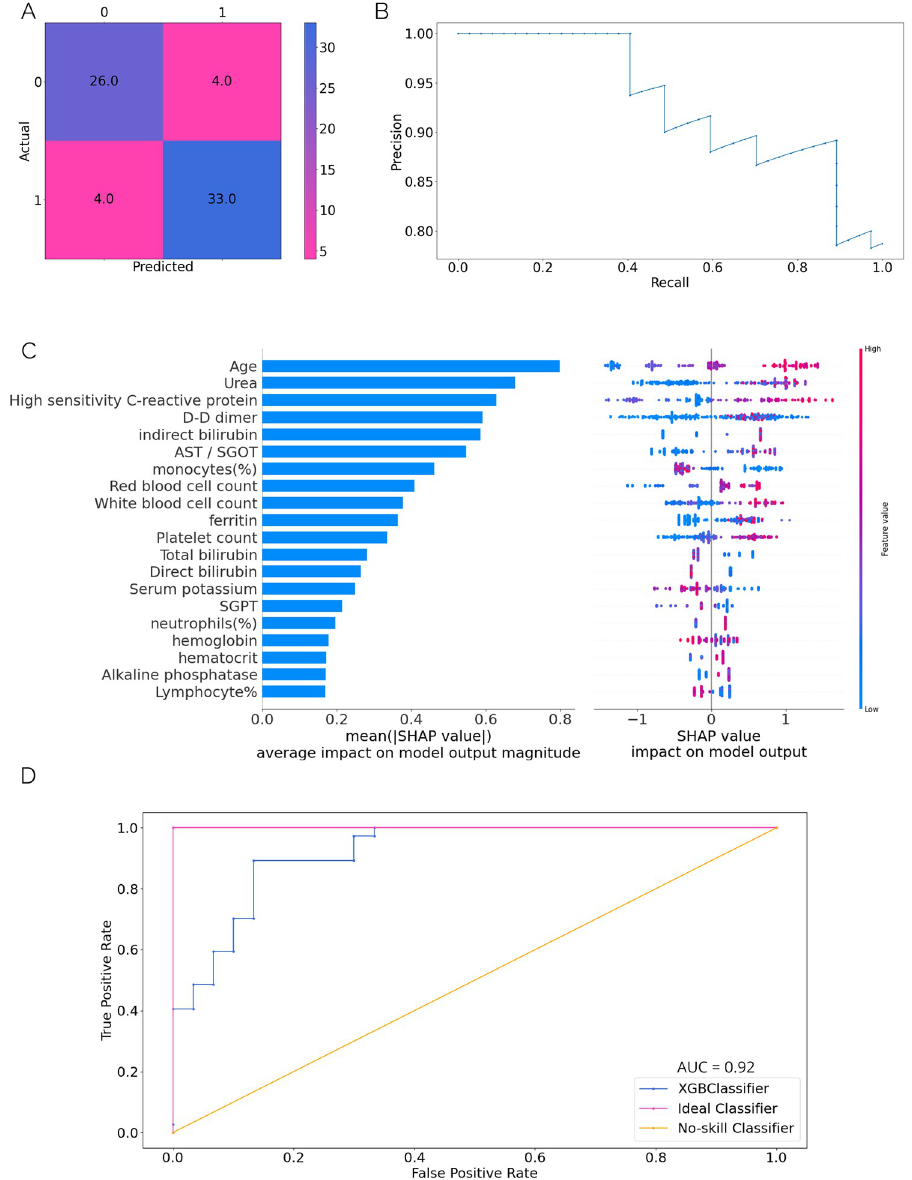
Fig 3. ( A) Confusion matrix for the severity model (B) Precision-Recall curve for the severity prediction model (C) Description of SHAP values for parameters with average impact on the model (left) and distribution of feature values (right) (D) ROC curve for the